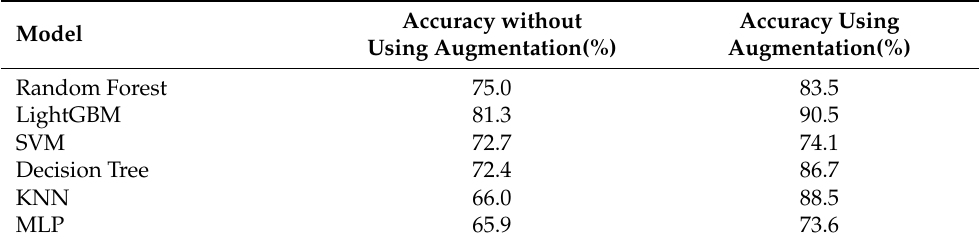
Table 7. Improvement of accuracy of classification model by using COM.